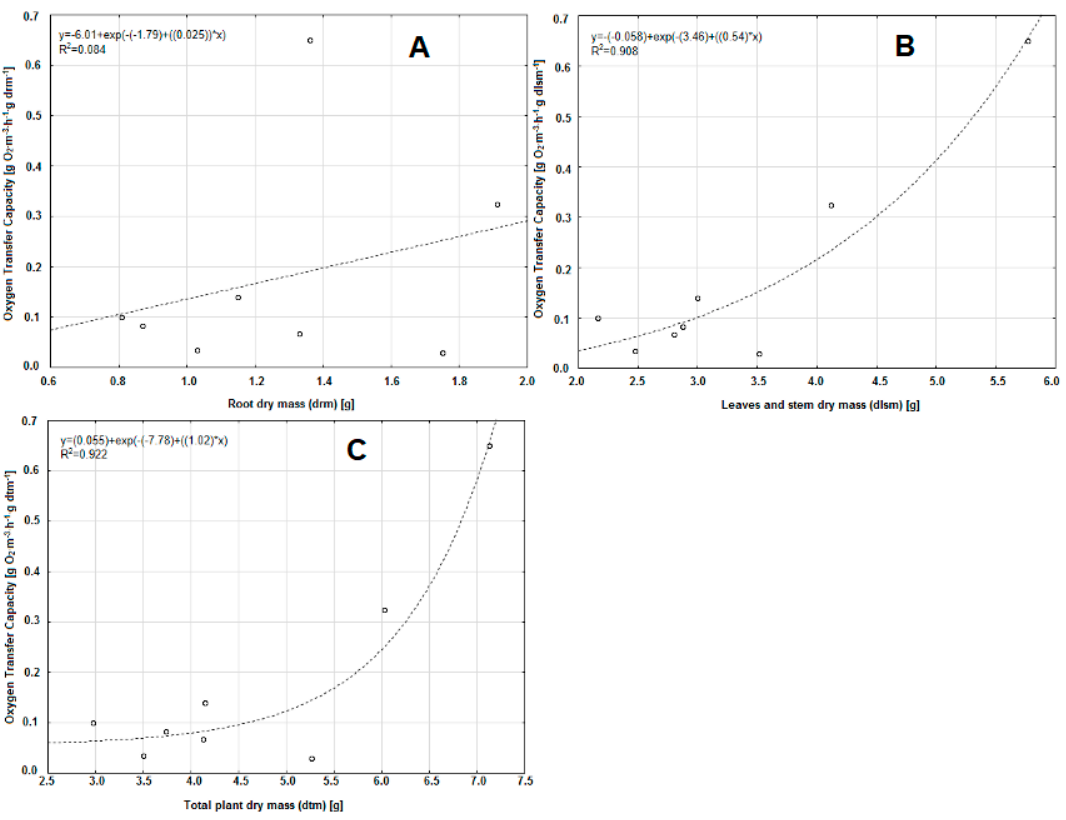
Figure 2. Relationships between the reed root dry mass ( A ); leaves and stem dry mass ( B ); total plant dry mass; ( C ) and oxygen transfer capacity (OTC).